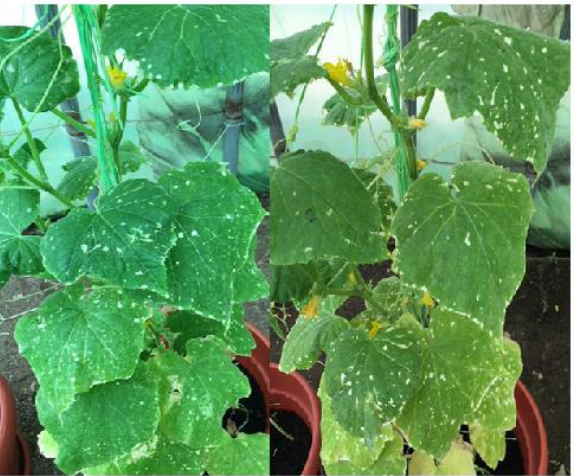
Figure 6. Adverse effects from an overdose application of essential oils on cucumber plants. Leaves show shiny spots and yellow or dead margins.